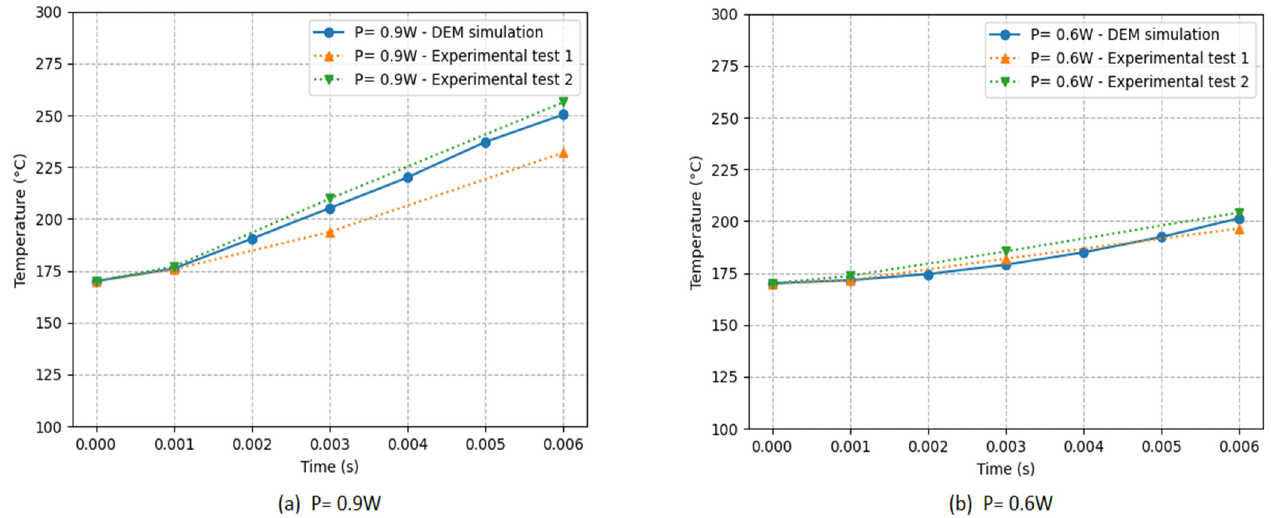
Figure 14. Comparison of the temperature evolution in the center laser beam of our DEM simulation with the [8] results using two different powers (a = 0.9 W, b = 0.6 W) and the data in Table 1. The left curve (a) shows the temperature evolution of the PA12 powder from our simulation DEM and the two experimental tests of Lanzl under the same laser power of 0.9 W for different exposure